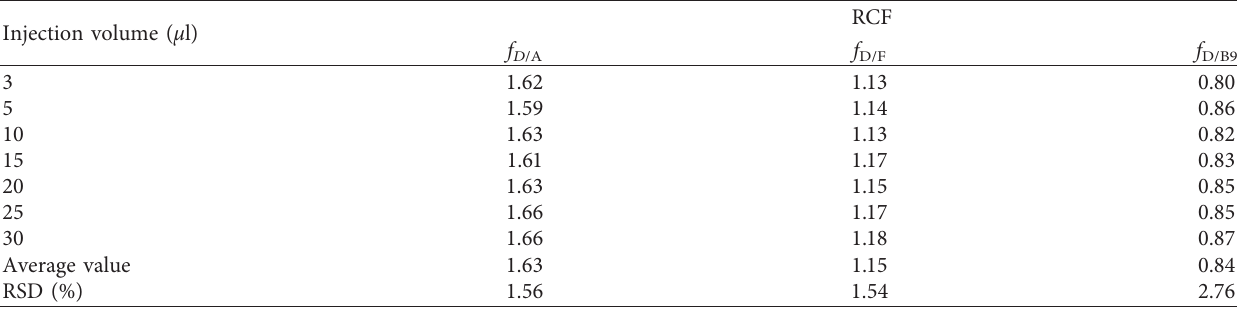
Table 3: RCF of 4 kinds of Pulsatilla